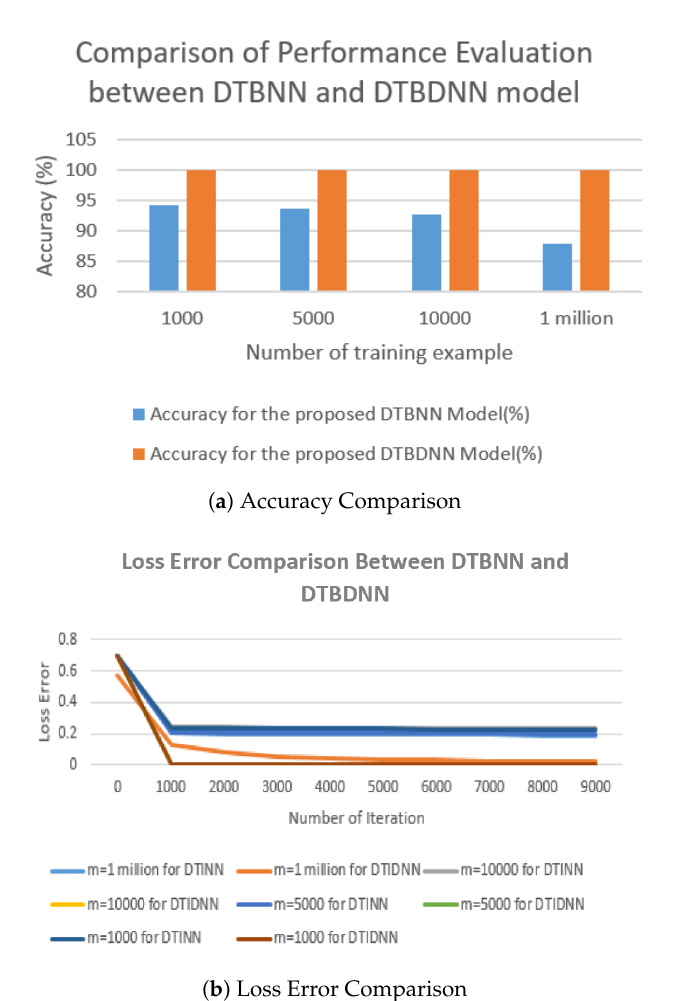
Figure 11. Comparison of performance evaluation between DTBNN and DTBDNN